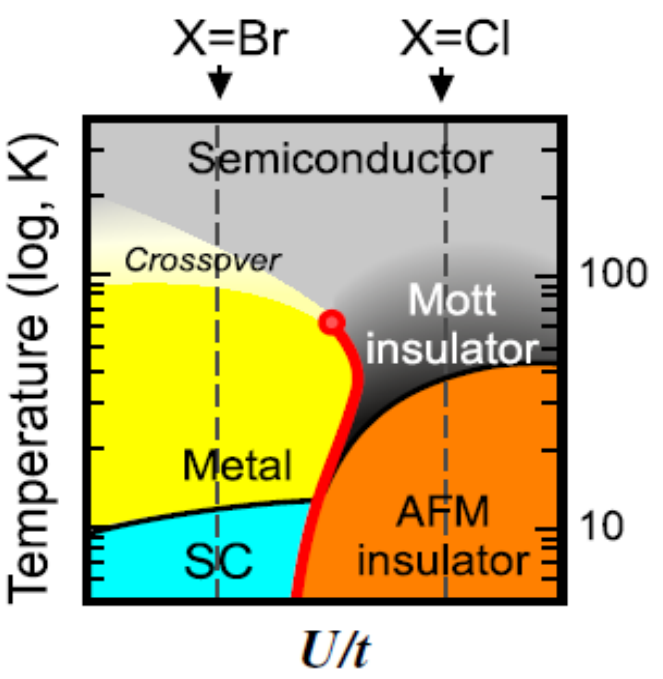
Figure 6. A schematic phase diagram of κ -(BEDT-TTF) 2 Cu[N(CN) 2 ]X (X = Br, Cl) complexes, which are considered typical, organic Mott insulators and superconductors depending on the anion X. An increase in the horizontal axis ( U / t ) corresponds to a decrease in the actual pressure. Adapted from Ref. [704] with permission.